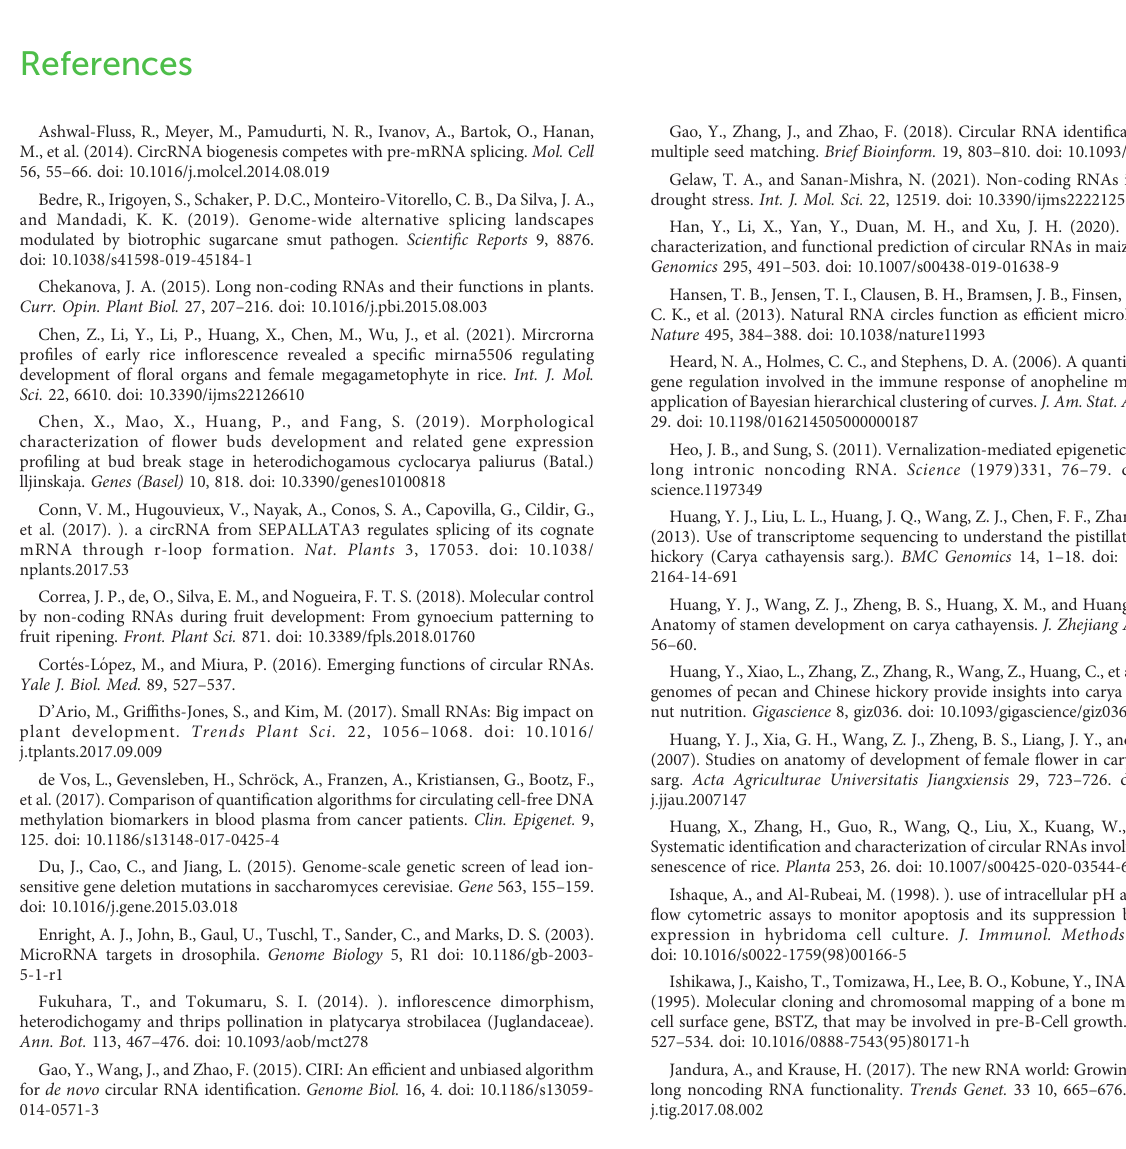
SUPPLEMENTARY TABLE 6 The clusters of circRNAs in female buds. SUPPLEMENTARY TABLE 7 The clusters of circRNAs in male buds. SUPPLEMENTARY TABLE 8 Gene ontology analysis in female buds. SUPPLEMENTARY TABLE 9 Gene ontology analysis in male buds. SUPPLEMENTARY TABLE 10 Flower-related differentially expressed circRNAs. SUPPLEMENTARY TABLE 11 The prediction of circRNA-miRNA-mRNA in F1 compared with F2.